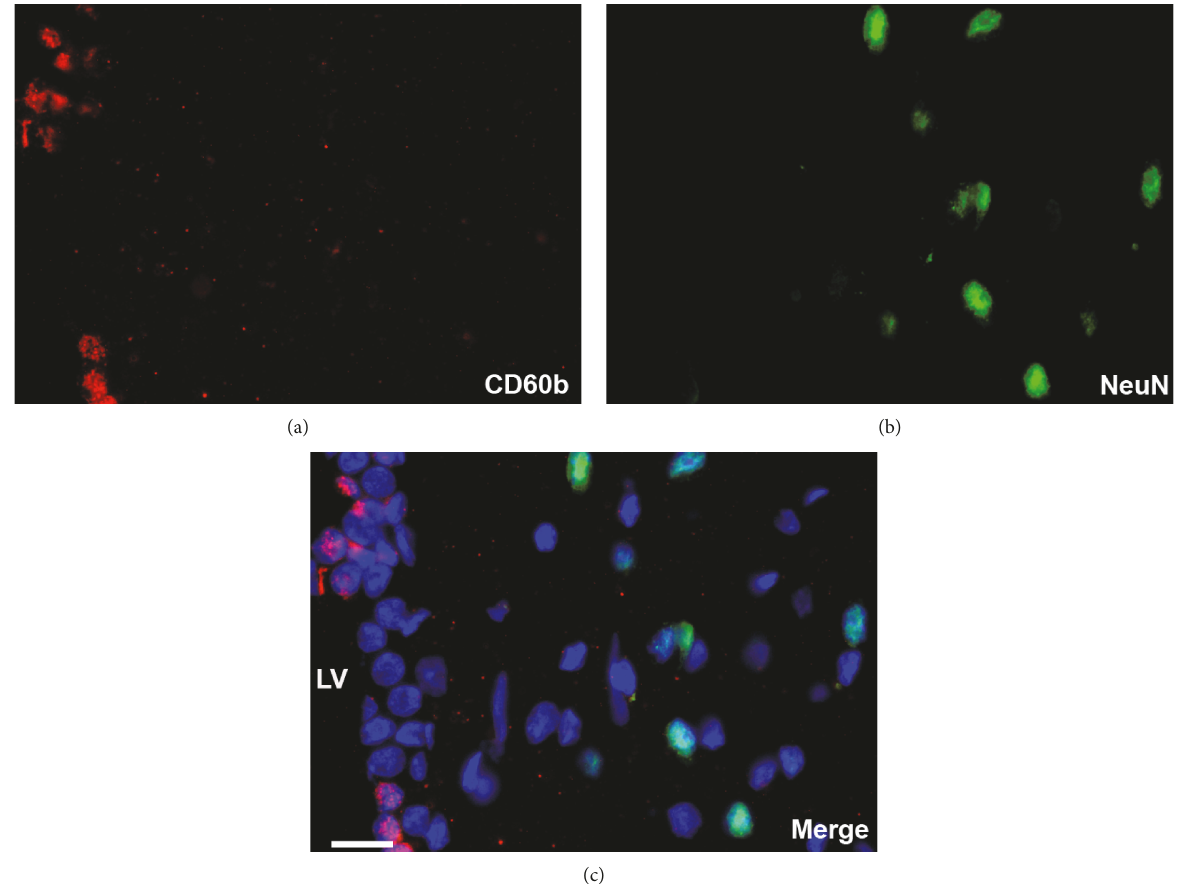
Figure 6: CD60b did not stain mature neurons. Confocal images of adult SVZ section showing the expression of CD60b ((a) in red) and NeuN ((b) in green). Nuclei stained with TO-PRO-3 in blue. Merge images showed no costained was observed between the two markers, demonstrating that CD60b is not expressed in mature neurons (c). CD60b expression could be observed only in the SVZ, lining the lateral ventricle. LV: lateral ventricle. Scale bar: 20 μ